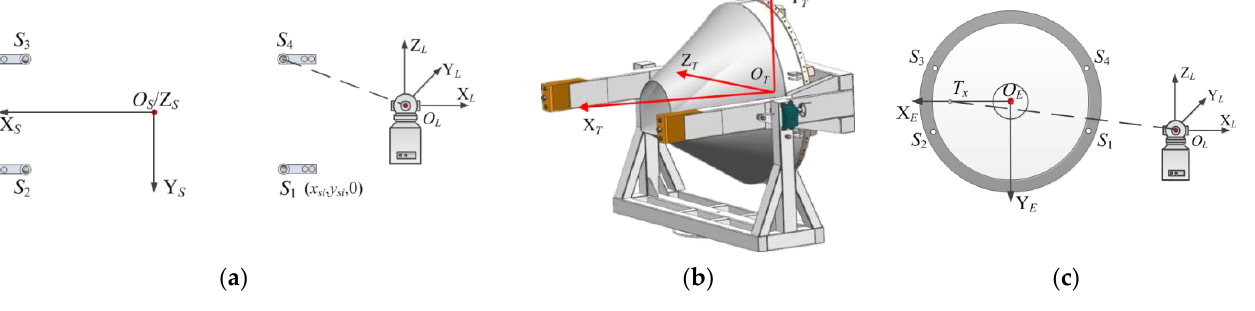
Figure 16. ( a ) The method of establishing SCS; ( b ) the method of establishing TCS; ( c ) the method of establishing ECS.